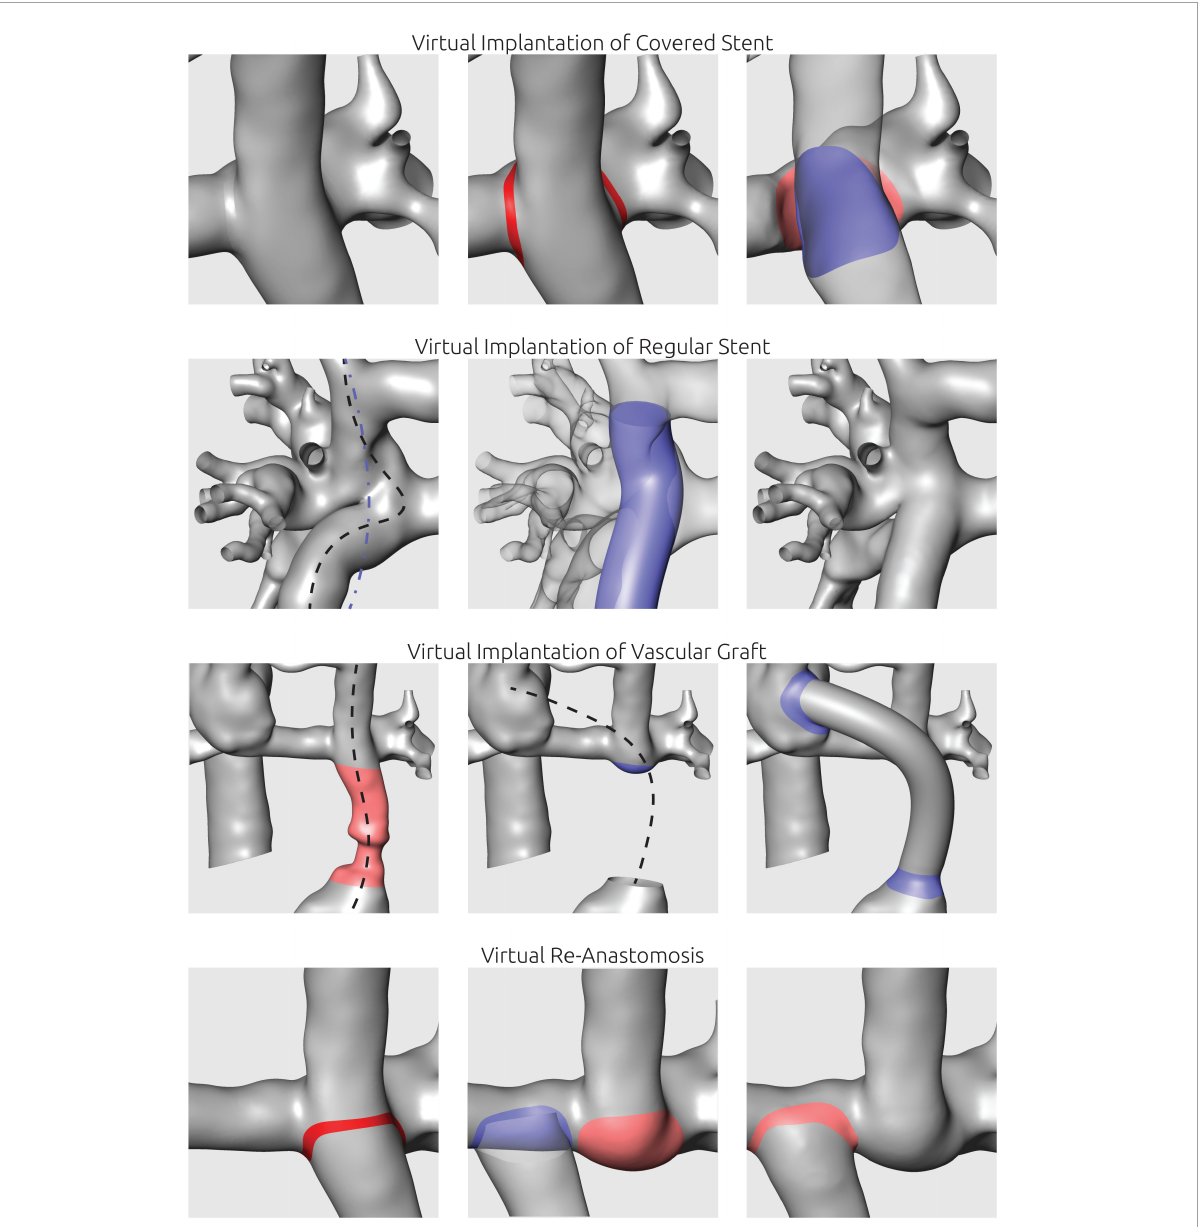
FIGURE2 Illustration of virtual manipulations to mimic interventional or surgical procedures. Virtual implantation of covered stents was utilized to separate two vessel lumina. Virtual stent implantation aimed at straightening of curved vascular paths using a manually defined spline (blue line). To mimic surgical implantation of vascular grafts, the respective vessel section was replaced using a tube following a manually positioned centerline. For virtual re-anastomosis, vessels were separated and shifted to the new anastomosis site.